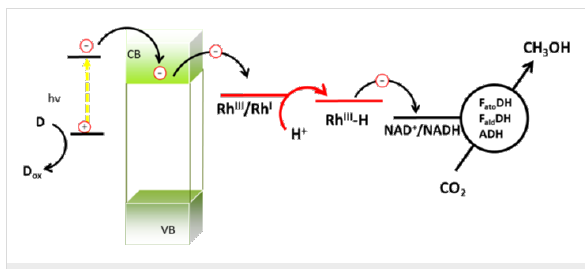
Figure 11: The electron flow in the photocatalytic system of NAD + reduction composed of the photosensitized TiO 2 photocatalyst, Rh(III)- electron mediator and glycerol as a sacrificial